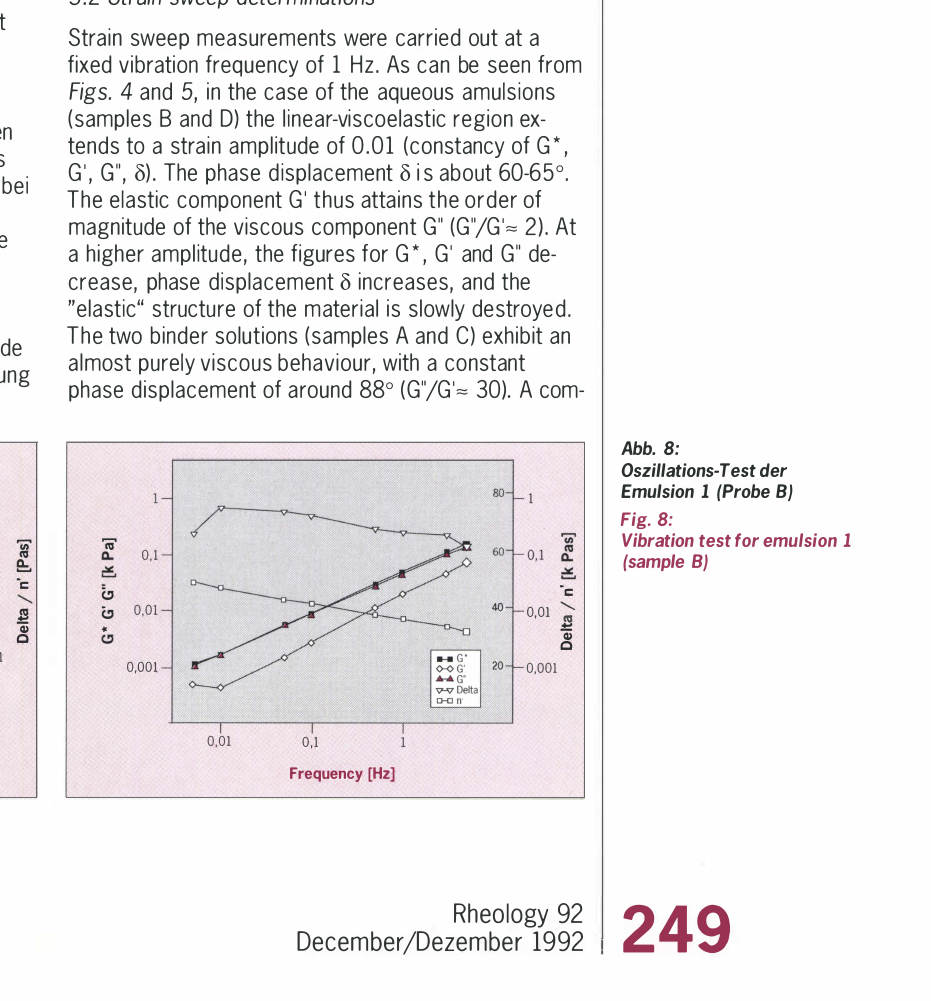
Fig. 7: Vibration test for binder solution 2 (sample C)